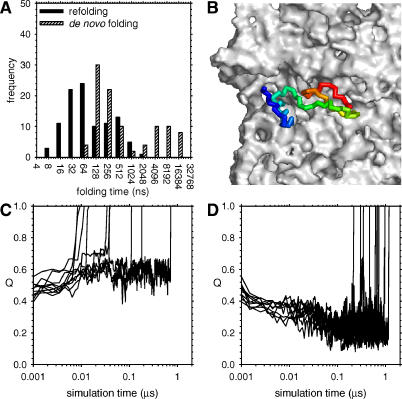
Consequences of Excessively Stabilizing CI2(A) Histograms of folding times obtained from refolding and de novo folding trajectories of CI2 with ɛ = 0.80 kcal/mol.(B) Snapshot of a “trapped” trajectory.(C) Plots of Q versus time for ten previously trapped trajectories when restarted without the ribosome.(D) Same as (C), but restarted with the ribosome and ɛ = 0.60 kcal/mol.